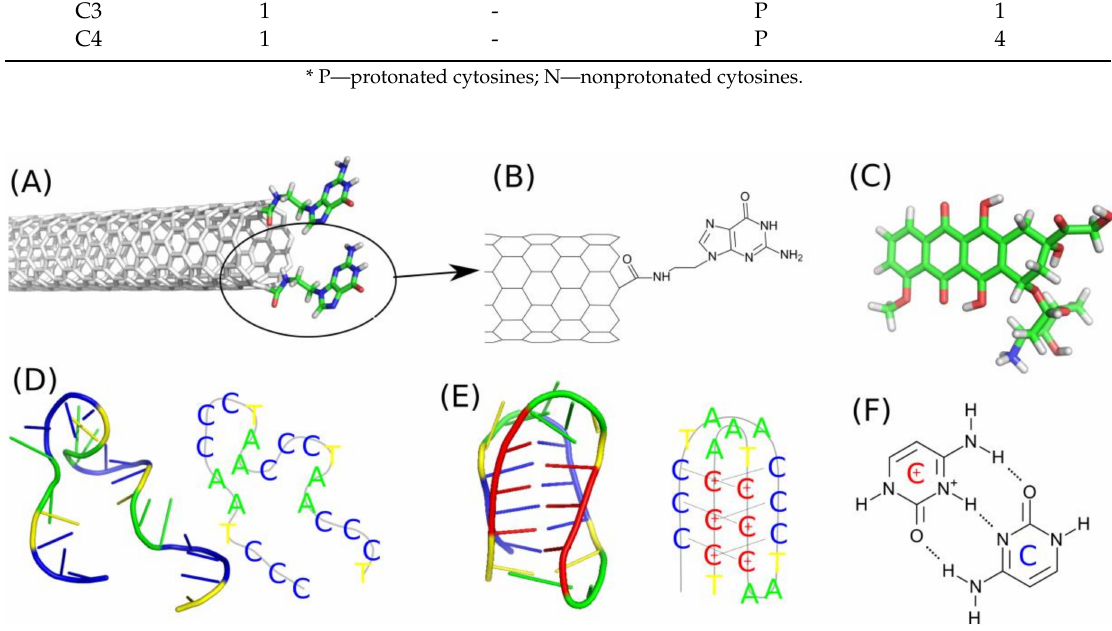
Figure 1. ( A ) Illustration of the applied functionalization of (10,0) carbon nanotube. ( B ) Schematic representation of the molecular topology of the guanine functional group attached to the CNT tip. ( C ) Doxorubicin molecule in its protonated form. ( D ) iMu - the telomeric fragment of ssDNA consisting of the sequence CCCTAACCCTAACCCTAACCCT in the radom coil form. ( E ) iMp - the fragment of ssDNA with semiprotonated cytosines CCCTAACCCTAAC + C + C + TAAC + C + C + T in the form of i-motif. ( F ) Triplet of hydrogen bonds formed between protonated C + and unprotonated cytosines C within the iMp